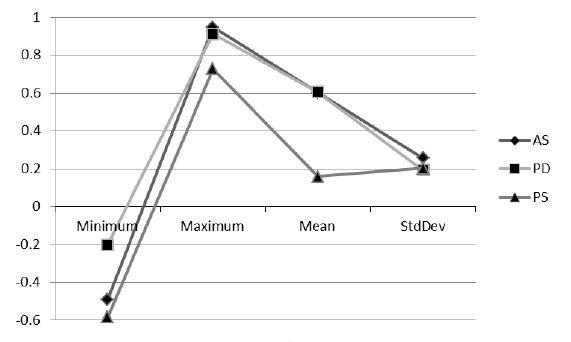
Figure 4. Graph of the NDVI values